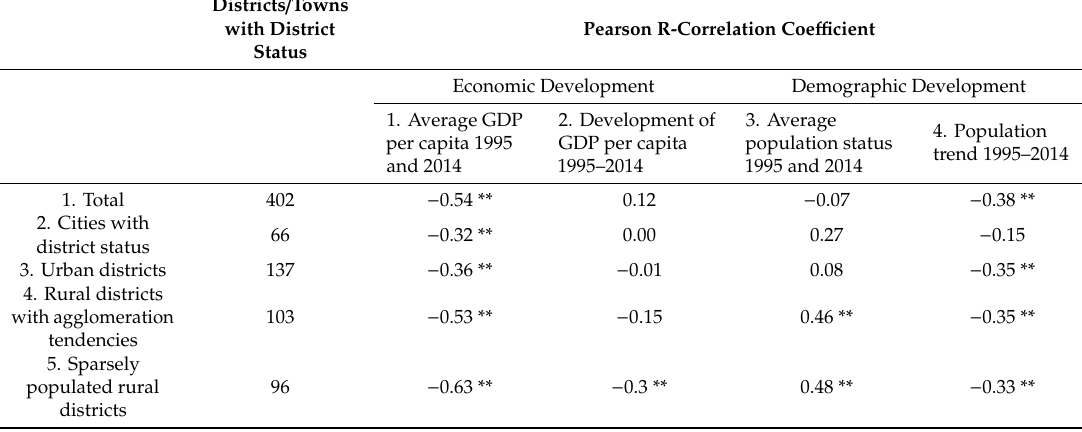
Table 4. Correlation between the number of funding programmes deployed and the economic growth / population trends of the German districts and towns with district status